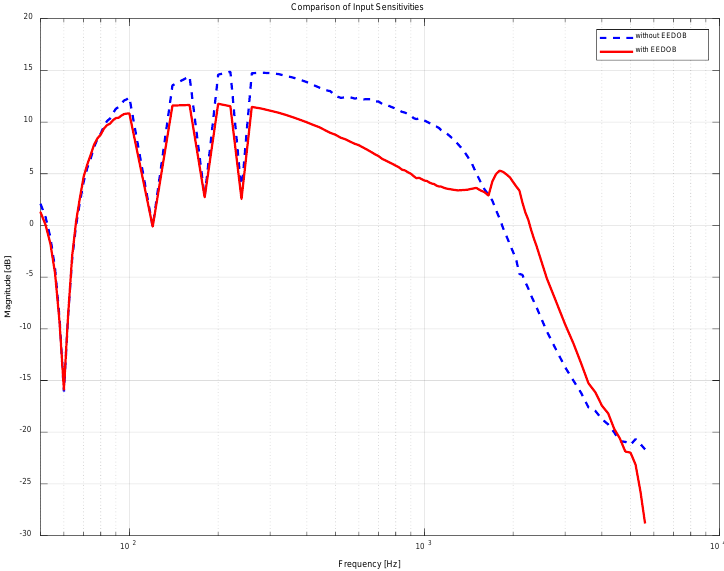
Figure 9. Input sensitivity functions from plant input disturbance to plant output.